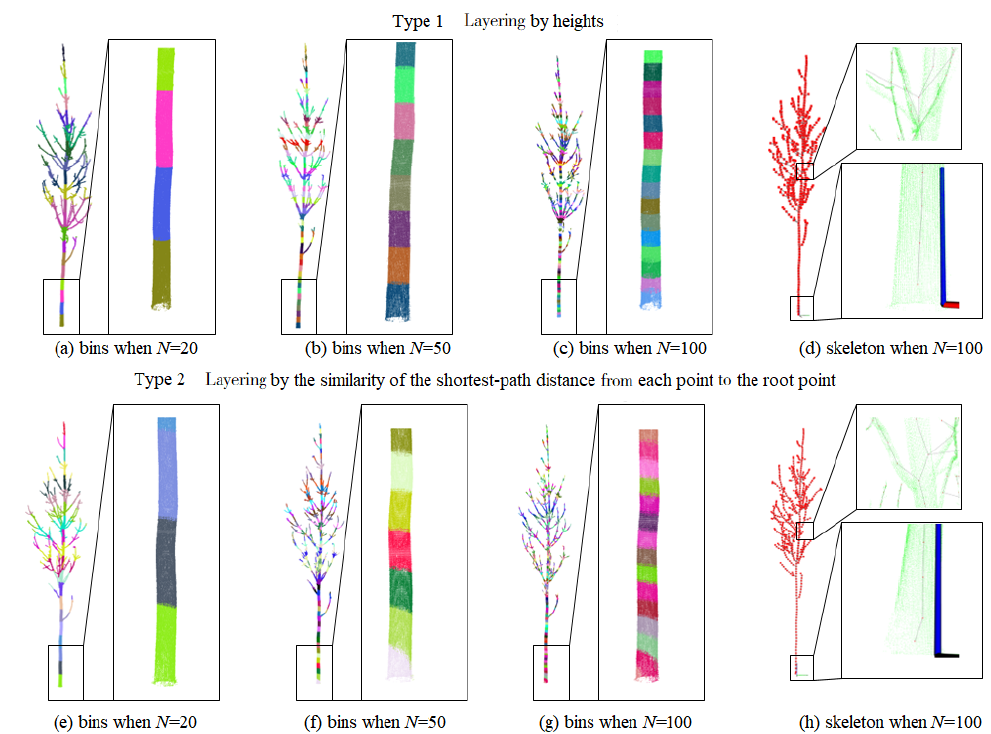
Figure 1. Effects of bins with different layers and the produced skeleton effect under two rules.